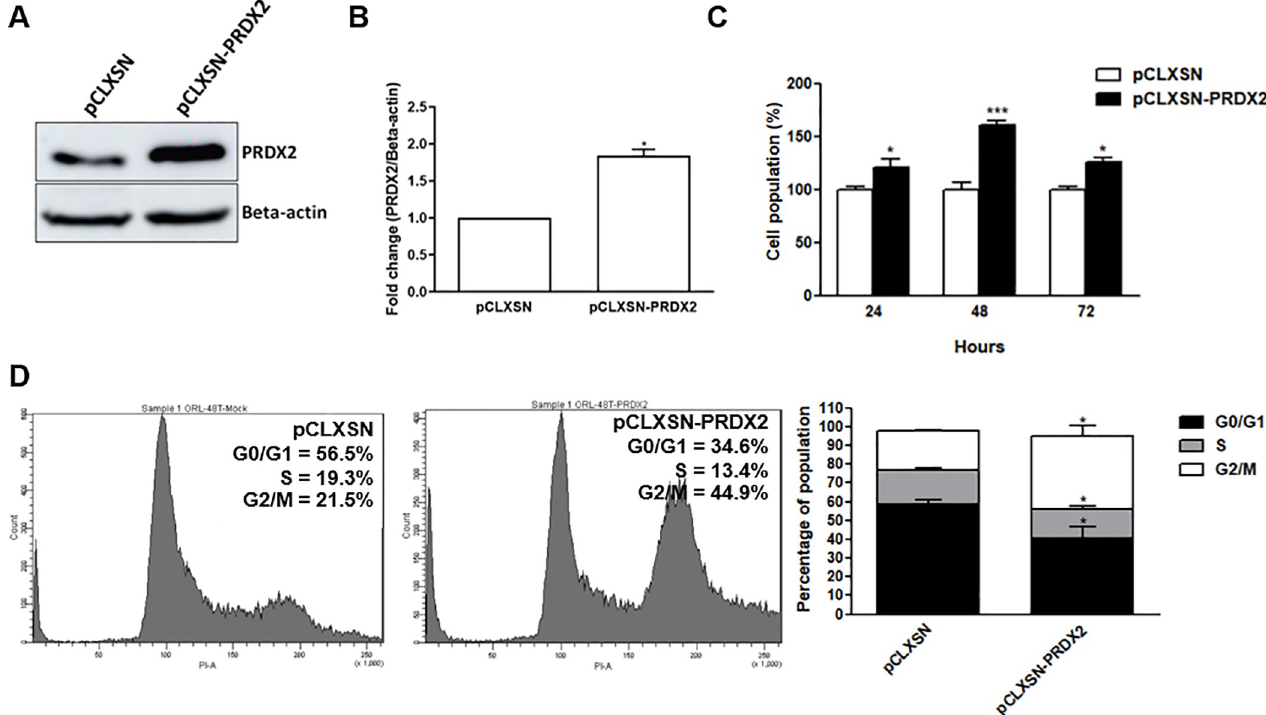
Fig 4. The effect of PRDX2 overexpression on cell proliferation and cell-cycle progression of ORL-48T cells. The level of PRDX2 protein in pCLXSN-PRDX2-transduced ORL-48T cells (A and B) was observed using western blot. Percentage of population of PRDX2-overexpressing ORL-48T cells relative to controls after incubation for 24, 48 and 72 hours was investigated by MTT assay (C). Differences in expression between pCLXSN and pCLXSN-PRDX2 were statistically analyzed using paired t-tests of triplicate experiments. Cell-cycle phase distribution in PRDX2-overexpressing ORL-48T cells incubated for 72 hours was determined by flow cytometry (D). Differences in expression and cell-cycle phase populations between pCLXSN and pCLXSN-PRDX2 were statistically analyzed using paired t-tests of triplicate experiments. � and ��� denote statistically significant differences as P < 0.05 and 0.001,